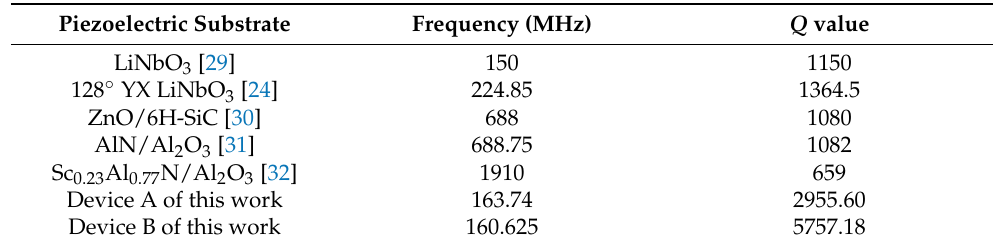
Table 4. Comparison works on the performance of SAW resonators at room